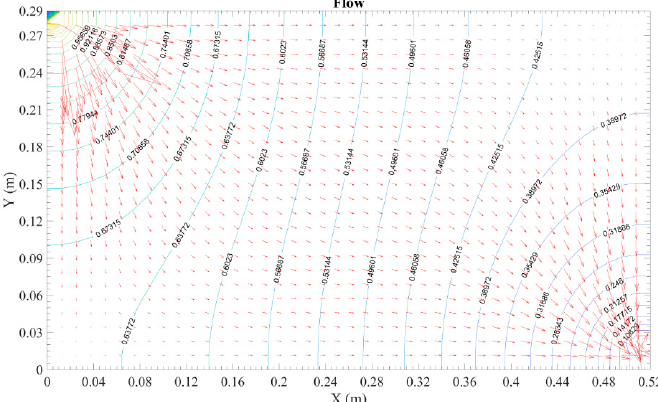
Figure 2 . Numerical simulation of the flow field inside the tank . Figure 2. Numerical simulation of the flow field inside the